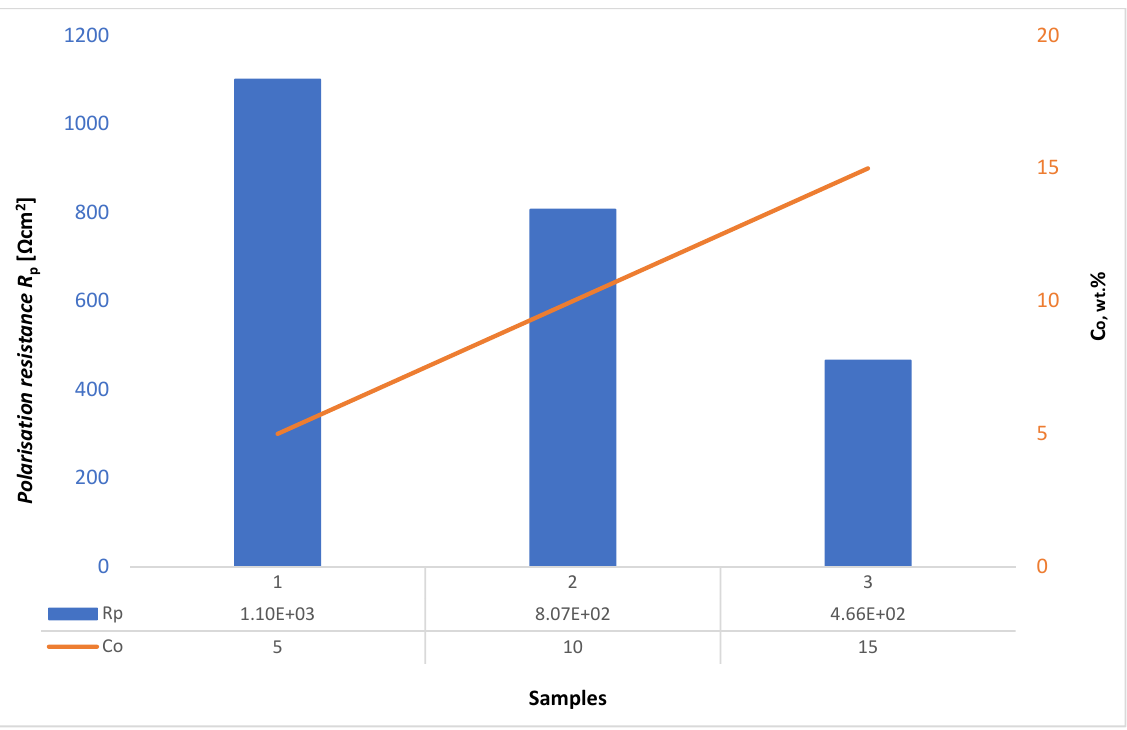
Figure 11. The dependence of R p concerning Co content.